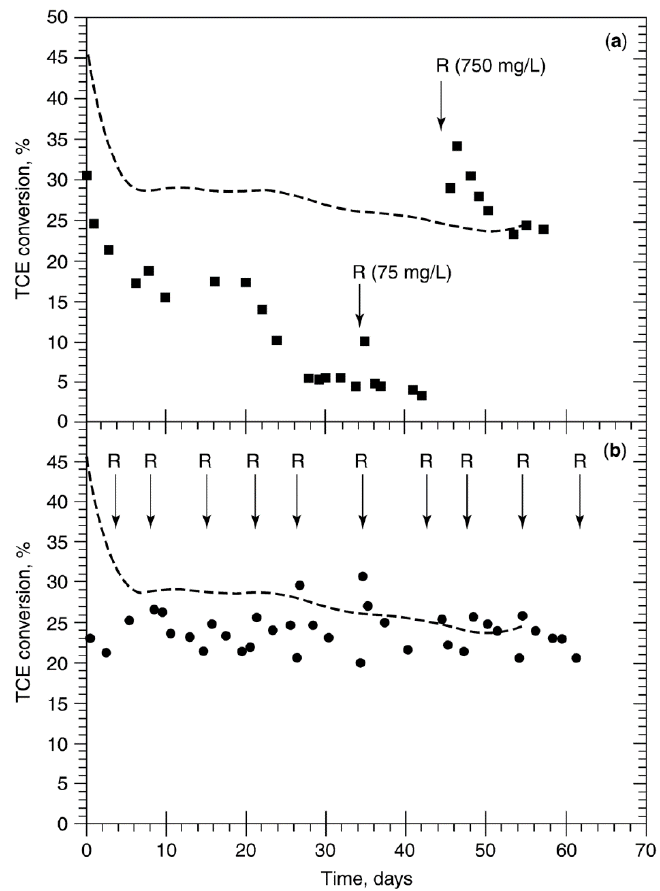
Figure 37. Effect of regeneration (R) with hypochlorite of Pd/Al 2 O 3 catalysts used for aqueous phase dechlorination of trichloroethylene in the presence of HS − /SO 32 . Reproduced from [286]. Copyright 1992, American Chemical